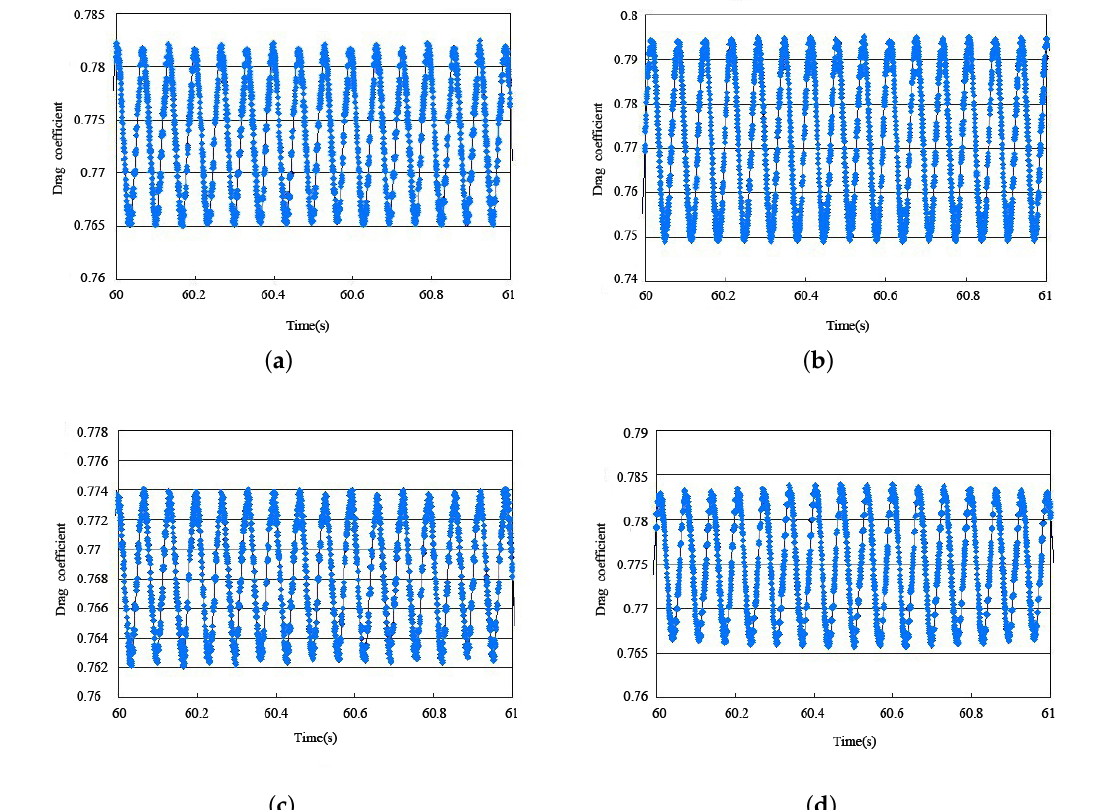
Figure 6. Variation curves of the drag coefficient of the TTR with time at different underwater depths: ( a ) drag coefficient curve at 1 m underwater; ( b ) drag coefficient curve at 2 m underwater; ( c ) drag coefficient curve at 3 m underwater; ( d ) drag coefficient curve of the entire